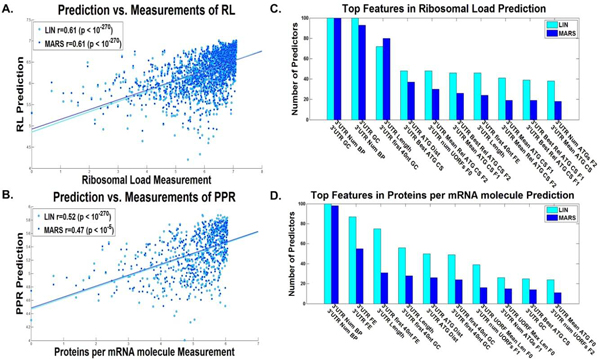
3'UTR linear and non-linear predictors results. Dot plot of the predictions vs. estimated measurements for the validation set of the predictor with the median results for the A. ribosomal load, and B. proteins per mRNA molecule, for the 3'UTR linear (LIN) and non-linear (MARS) predictors (Additional file 1: Supplementary Methods). The best features according to the number of predictors they participated in (Additional file 1: Supplementary Methods) of the C. ribosomal load predictor, and D. proteins per mRNA molecule predictor, for the 3'UTR linear (LIN) and non-linear (MARS) predictors (Additional file 1: Supplementary Methods).